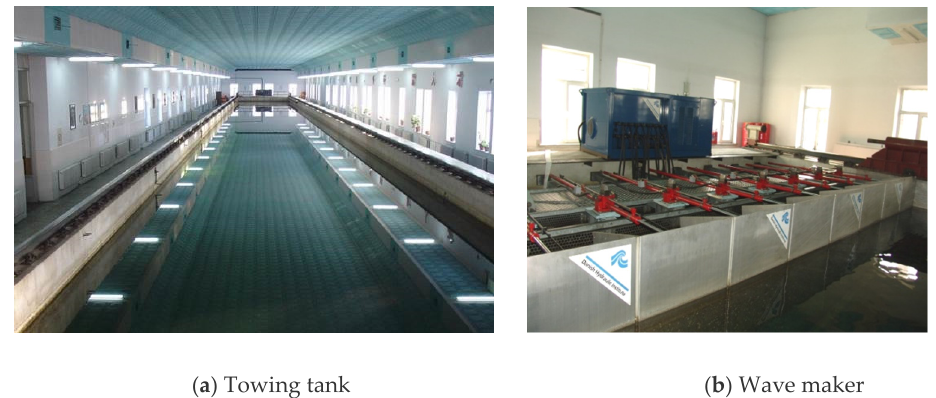
Figure 17. Experimental facilities.